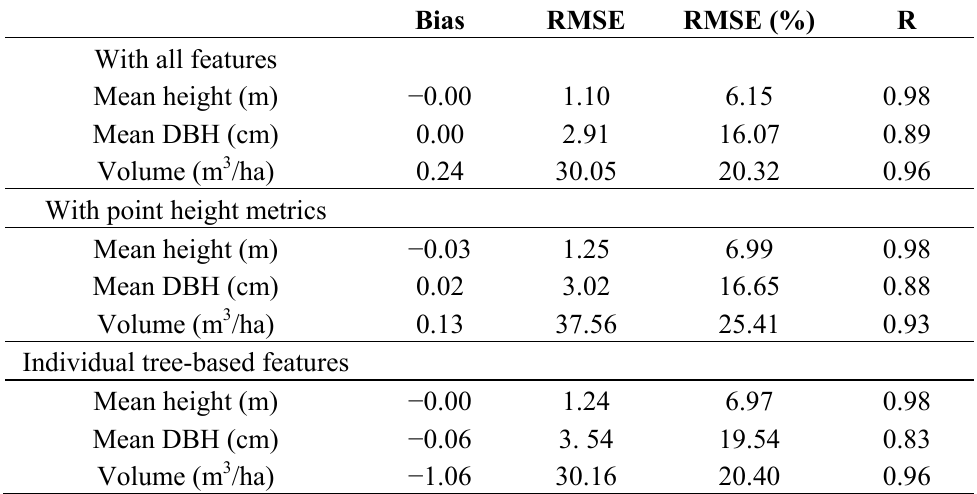
Table 3. The bias, RMSE, and correlation coefficient (R) between the predicted and observed values were calculated as measures of the accuracy of area-based inventory based on three different feature